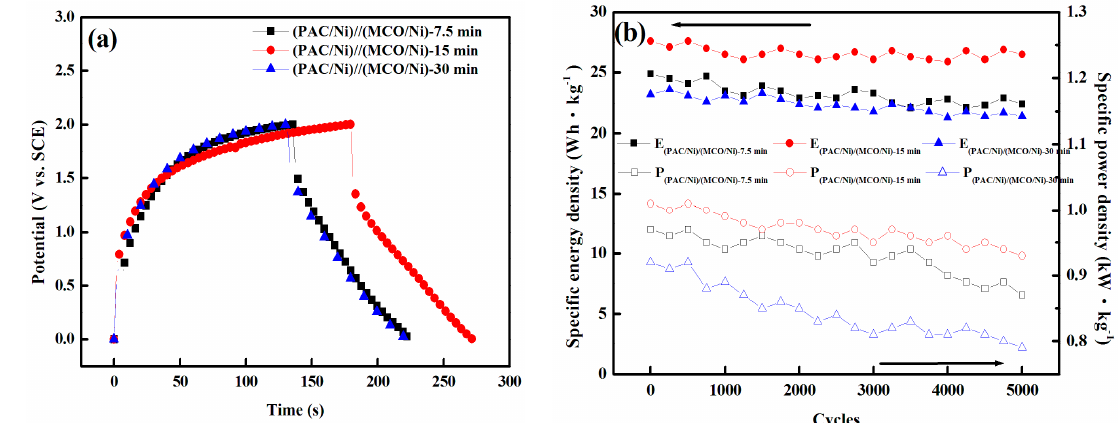
Figure 5. Performance of asymmetric PAC/Mn 1.5 Co 1.5 O 4 device using MCO/Ni as positive electrode and PAC as negative electrode. ( a ) Charge-discharge curves of (PAC/Ni)//(MCO/Ni)-7.5 min, (PAC/Ni)//(MCO/Ni)-15 min, and (PAC/Ni)//(MCO/Ni)-30 min; and ( b ) Cycling stability test of (PAC/Ni)//(MCO/Ni)-7.5 min, (PAC/Ni)//(MCO/Ni)-15 min, and (PAC/Ni)//(MCO/Ni)-30 min devices.